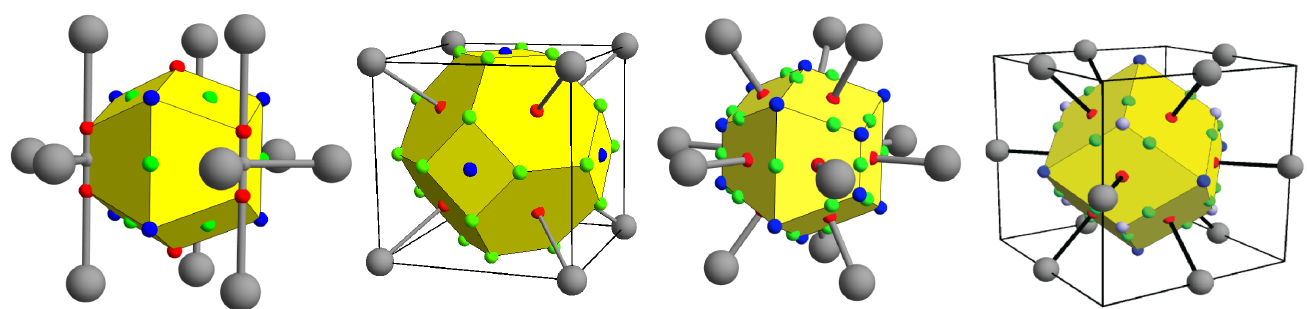
Figure 2. From left to right, the topology of the non-magnetic transition metals of: the early HCP metals of columns 3 and 4; the BCC metals of columns 5 and 6; the late HCP transition metals of columns 7 and 8; and the FCC metals of columns 9, 10, and 11.The yellow polyhedra are the boundaries of the Wigner–Seitz cell about a central atom. The large gray spheres mark the locations of the atoms in the first coordination sphere. Throughout this paper, small grey, red, green, and blue spheres denote pseudo atom, bond, ring, and cage CPs, respectively. Bond paths connecting the first coordination sphere to the central atom are shown as